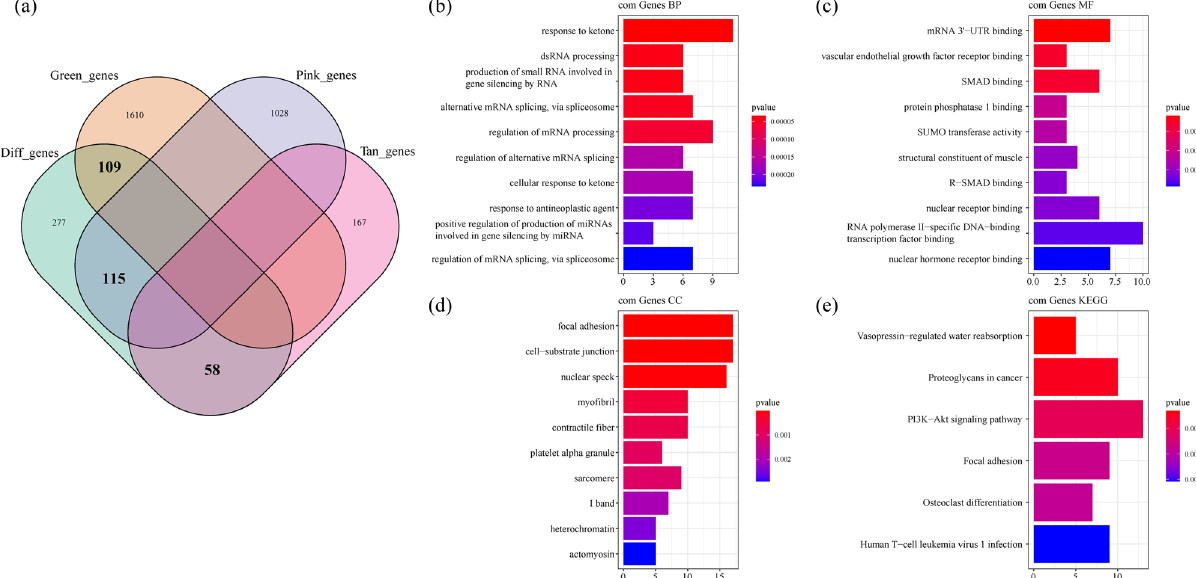
Figure 6: Identi fi cation of co - expression of DEGs: ( a ) Venn diagram of co - expressed genes and DEGs, ( b ) the BP annotation map of co - expression of DEGs, ( c ) the CC annotation map of co - expression of DEGs, ( d ) the MF annotation map of co - expression of DEGs, and ( e ) the KEGG annotation map of co - expression of